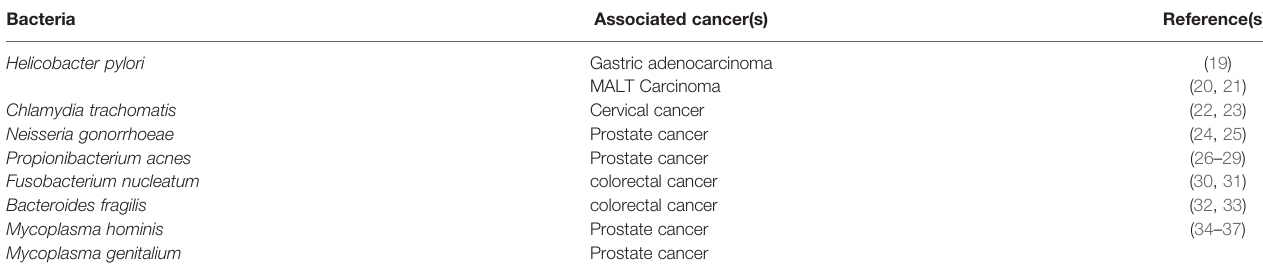
TABLE 1.1 | Bacteria implicated in oncogenesis; factors and mechanisms facilitating oncogenesis.